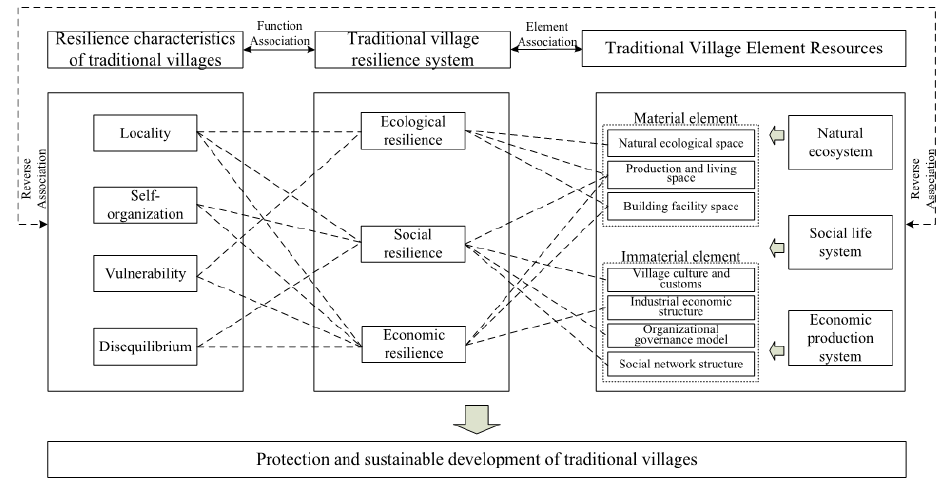
Figure 2. Correlation framework of resilience theory–protection and development of traditional villages.